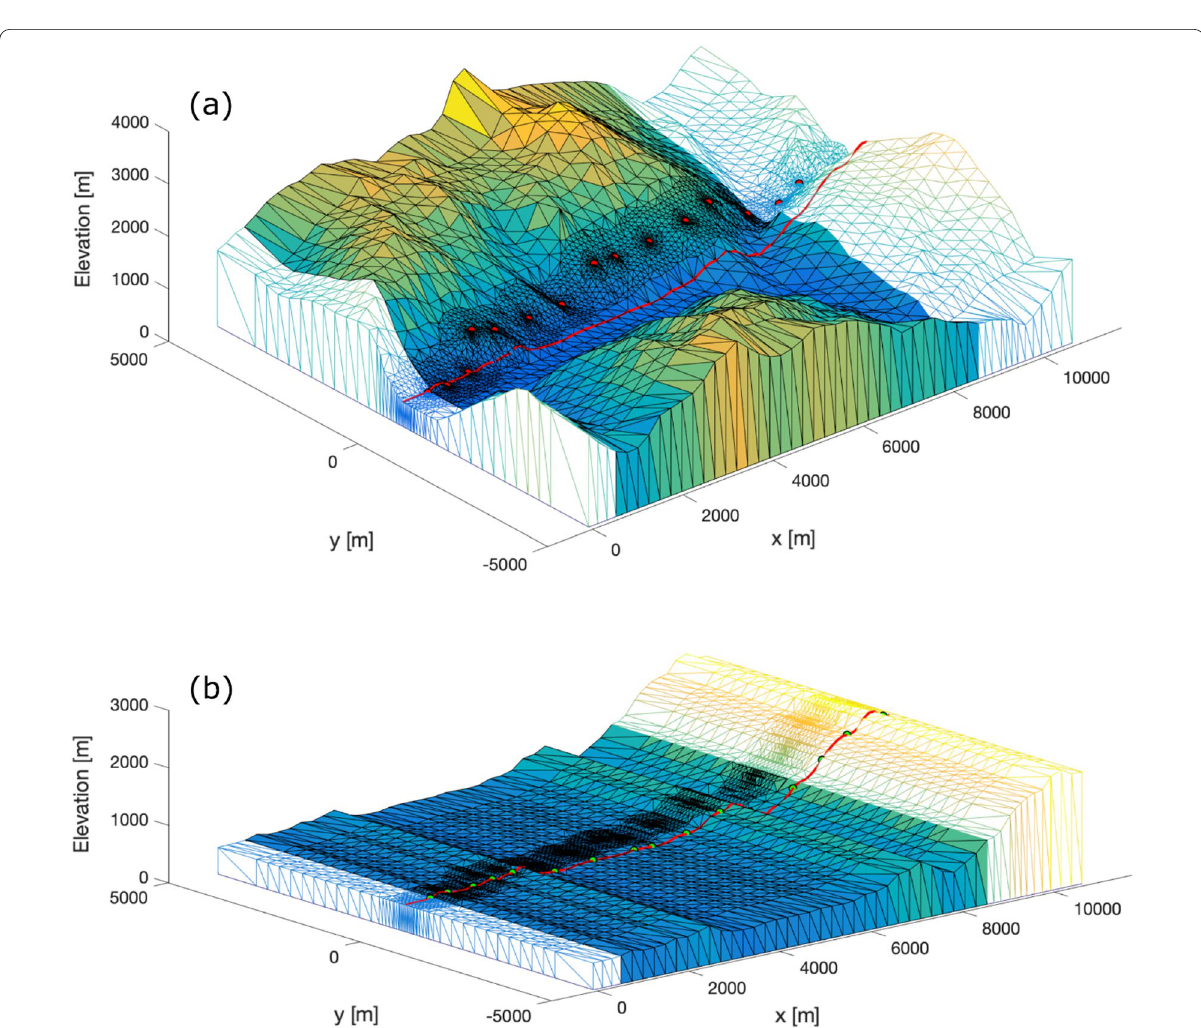
Fig. 7 a Initial real-world situation at the northern tunnel portal. The 3D topography is interpolated at mesh nodes from the swissALTI3D DEM. The topographic mesh coloured by elevation is associated with a single unit as indicated by the 2D GBT geological profile, while the neighbouring units are shown with coloured mesh edges only. The mesh resolution is higher in the vicinity of the surface gravity measurement points (red circles) and in the vicinity of the reference model line (red line), which is by definition at y 0 m along the whole study area. The topography sampled along the = reference model line corresponds to the reference model topographic profile, and it is the same profile to which the geological profile was adapted, and which is used for the synthetic gravity computation. b Final, adapted reference model situation of the same area at the northern tunnel portal. View of the 2.5D topography as laterally continued from the 2D reference model line topographic profile (red line). This 2.5D structure is correctly accounted for by our forward gravity modelling routine, which neglects any topography variation along the profile-perpendicular coordinate (Won & Bevis, 1987). The red line following the topographic profile at y 0 m represents the 2D reference model line, to which the observed gravity = measurements are translated (green circles) prior to the comparison with the synthetic values. The newly introduced terrain-adaptation correction (TAC, see Sect. 4.2.3) takes care of all changes from a to b . It should be noted that the spatial extent of each unit block guarantees the consideration of topographical masses for a minimum radius of 167 km around each gravity measurement, and that horizontal axes in panels a and b